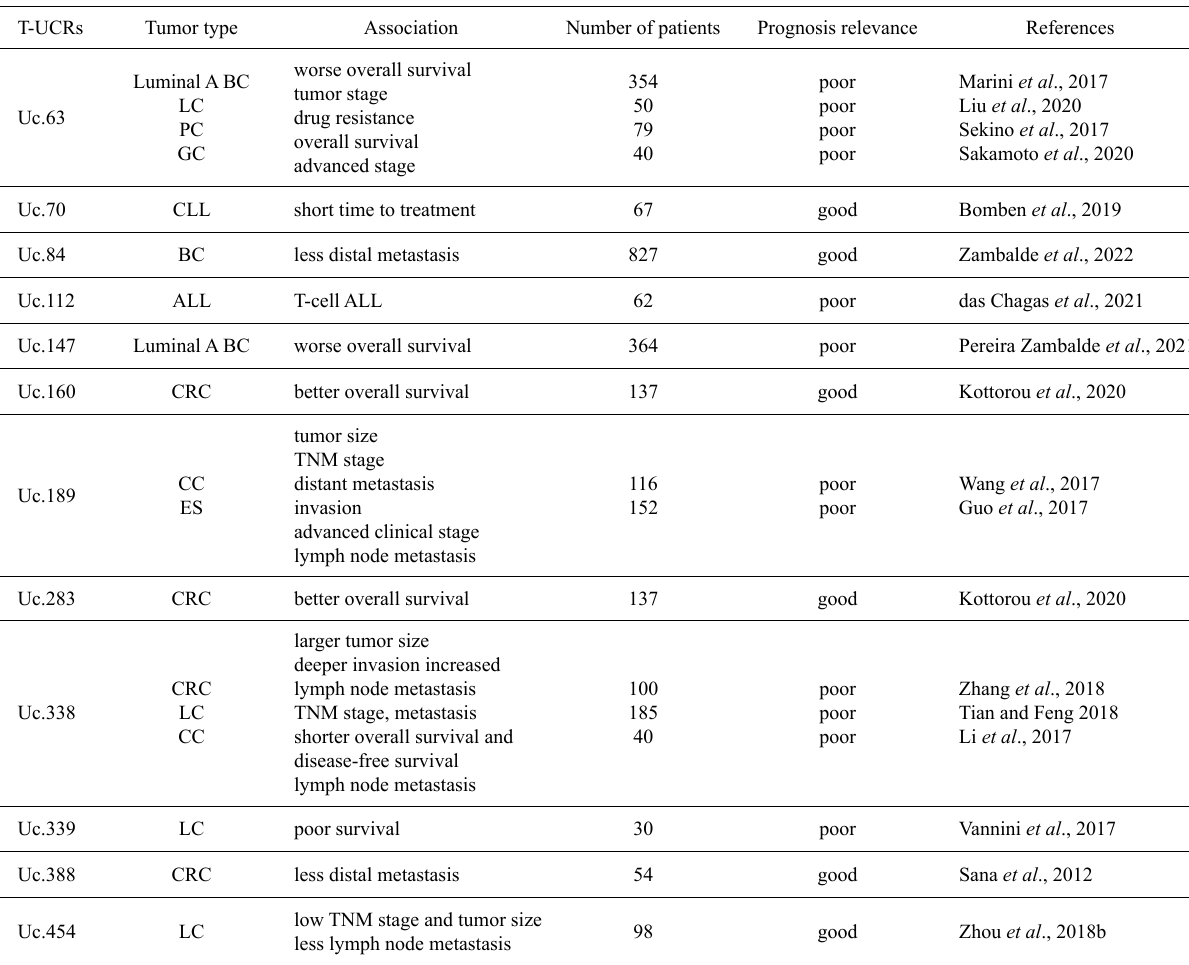
Table 1 – T-UCRs with potential utility as prognosis marker in human cancers.